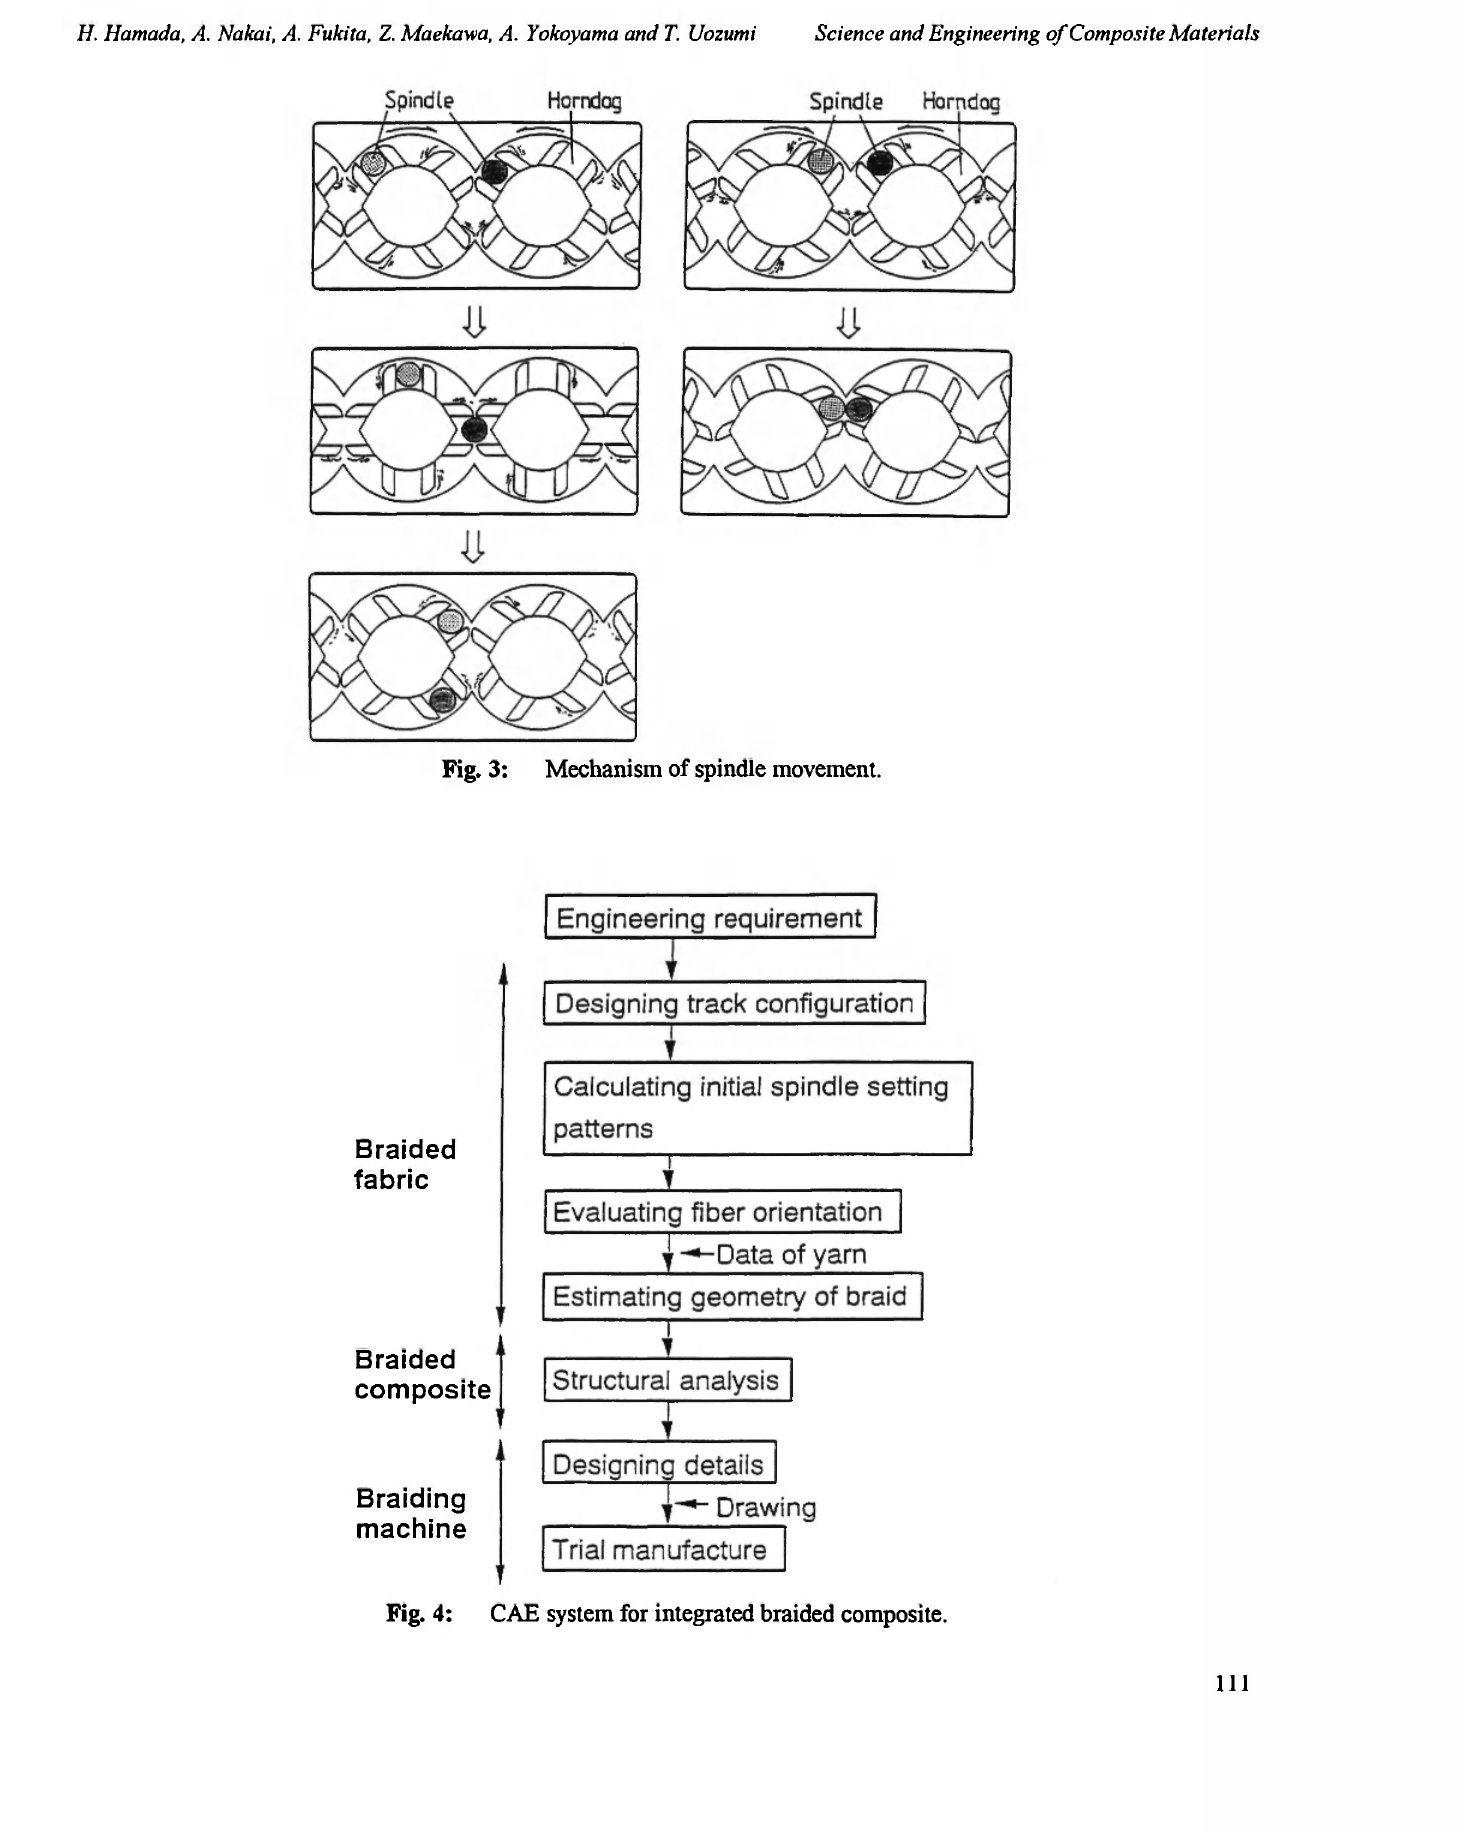
Fig. 3: Mechanism of spindle movement.